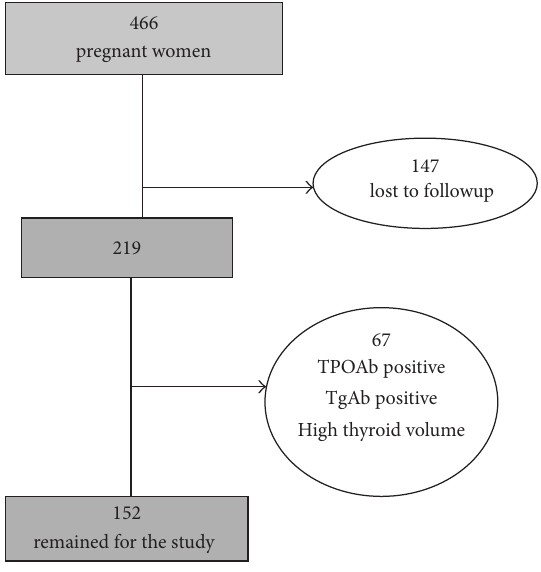
At initial presentation, before the end of the first trimester, three urine samples and in each of the second and third trimesters one urine sample were obtained for measurement of urinary iodine concentration (UIC). In all of the